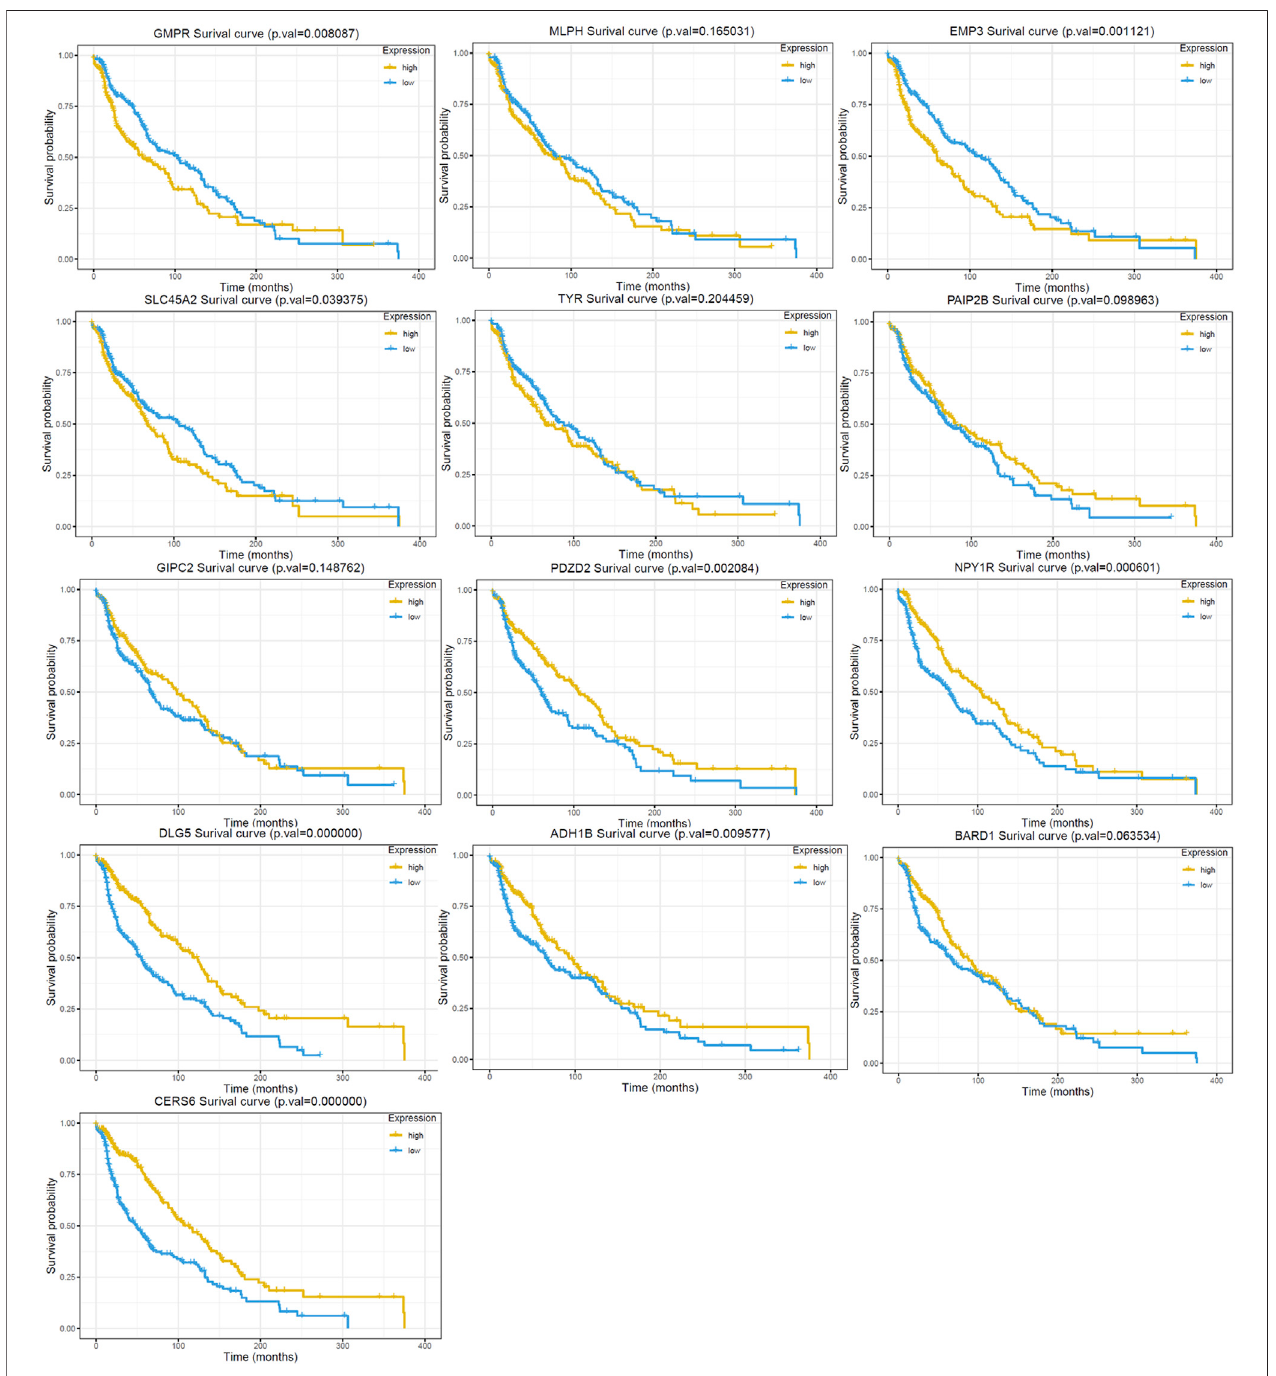
FIGURE 5 | Kaplan Meier survival curve of the 13 DEGs in the RRA analysis. The GMPR, MLPH, EMP3, SLC45A2 and TYR are up-regulated in GEO dataset. The PAIP2B, GIPC2, PDZD2, NPY1R, DLG5, ADH1B, BARD1 and CERS6 are down-regulated in GEO dataset.